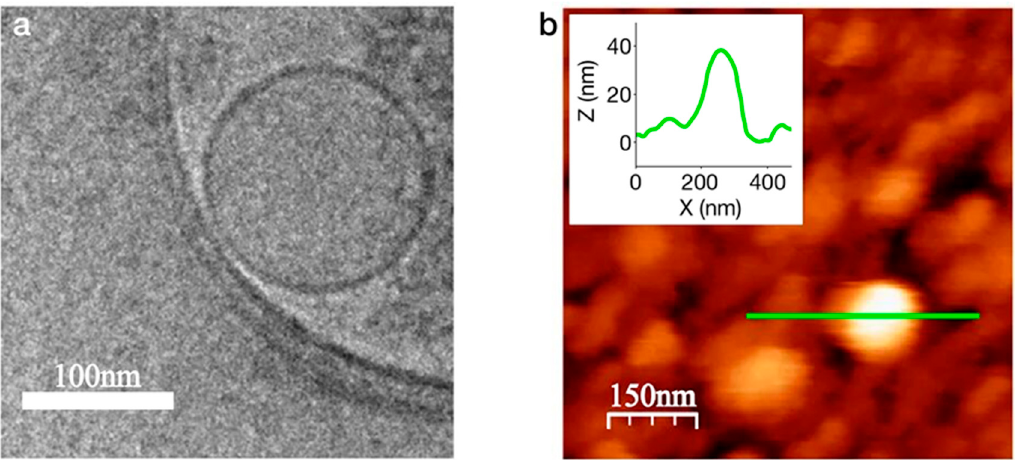
Figure 4. OR-containing nanovesicles. ( a ) Nanovesicles generated from Saccharomyces cerevisiae expressing the human OR17-40 are characterized by 2D cryo-EM. Average size of the spheres measures ~ 100 nm. ( b ) An AFM tapping mode image showing the nanovesicles deposited on a gold surface functionalized with –COOH self-assembled monolayer. Reprinted with permission from Sanmartí-Espinal et al. copyright © (2017) [71].